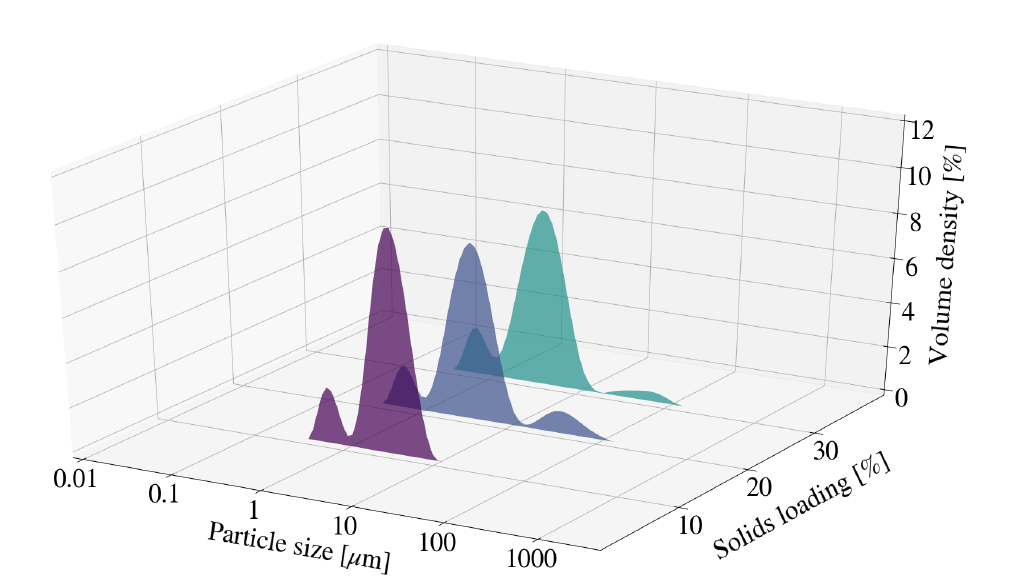
Figure 6. Particle size distribution for Mg-Al LDH samples synthesised at a cooling water inlet temperature of 30 °C, with a change in solids loading (S2, S7,